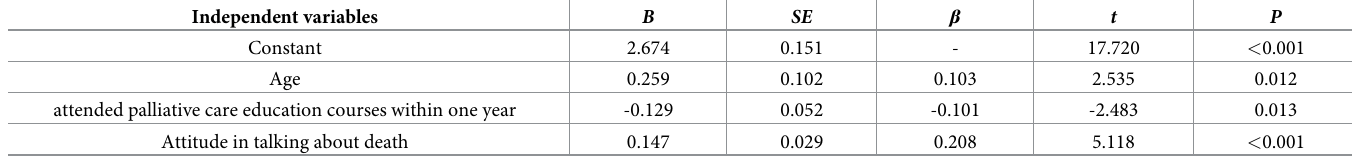
Table 6. Regression analysis of the DCS of nurses.